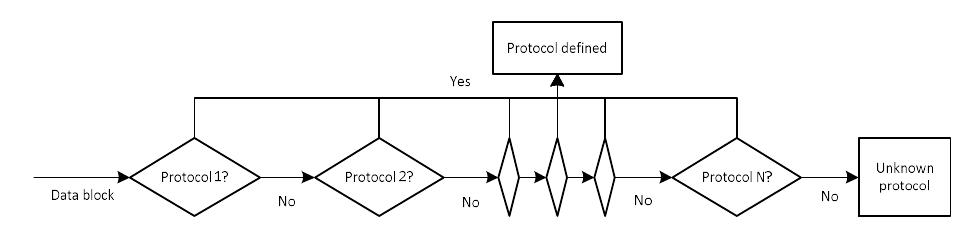
Figure 9. Sequential algorithm of detection.